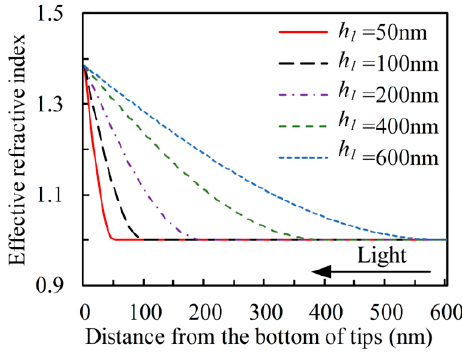
Figure 4. Effective refractive index of micro ‐ nano structures with different heights of tips varied with the distance from the bottom of tips.